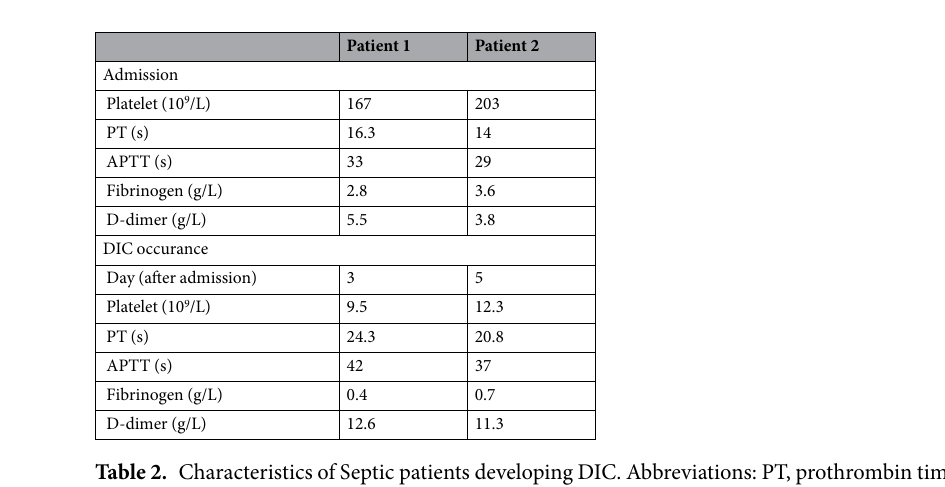
Table 2. Characteristics of Septic patients developing DIC. Abbreviations: PT, prothrombin time; APTT, activated partial thromboplastin time; DIC, disseminated intravascular